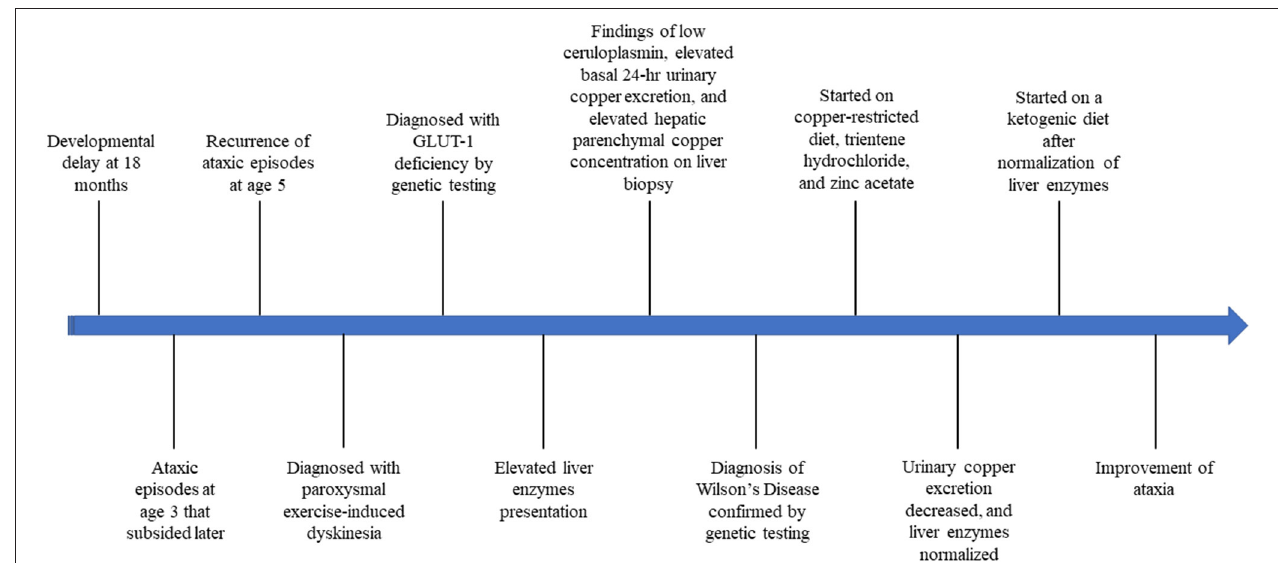
Frontiers in Pediatrics |